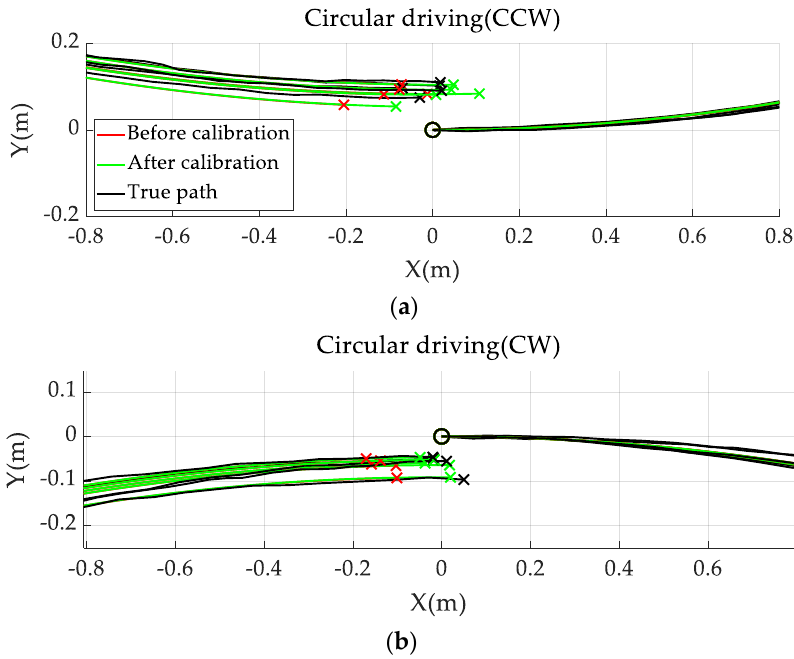
Figure 5. Result for the circular path before and after calibration. Comparison of circular path results: ( a ) counterclockwise (CCW); ( b ) clockwise (CW).